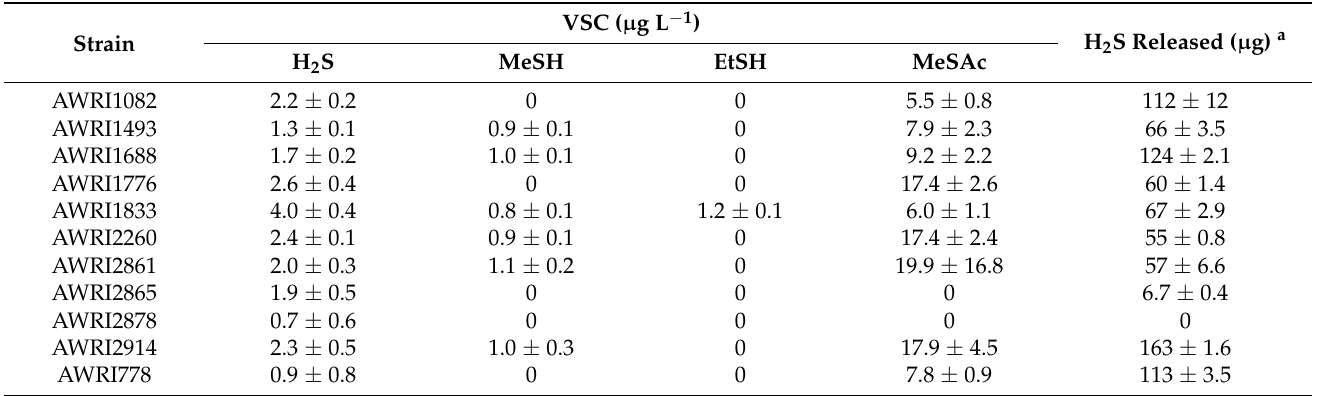
Table 3. Effect of different yeast strains in VSC formation after Pinot Noir fermentation.